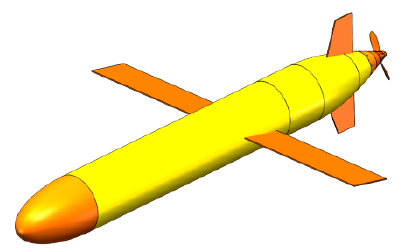
Figure 1. Schematic diagram of the zero-angle-of-attack glider.